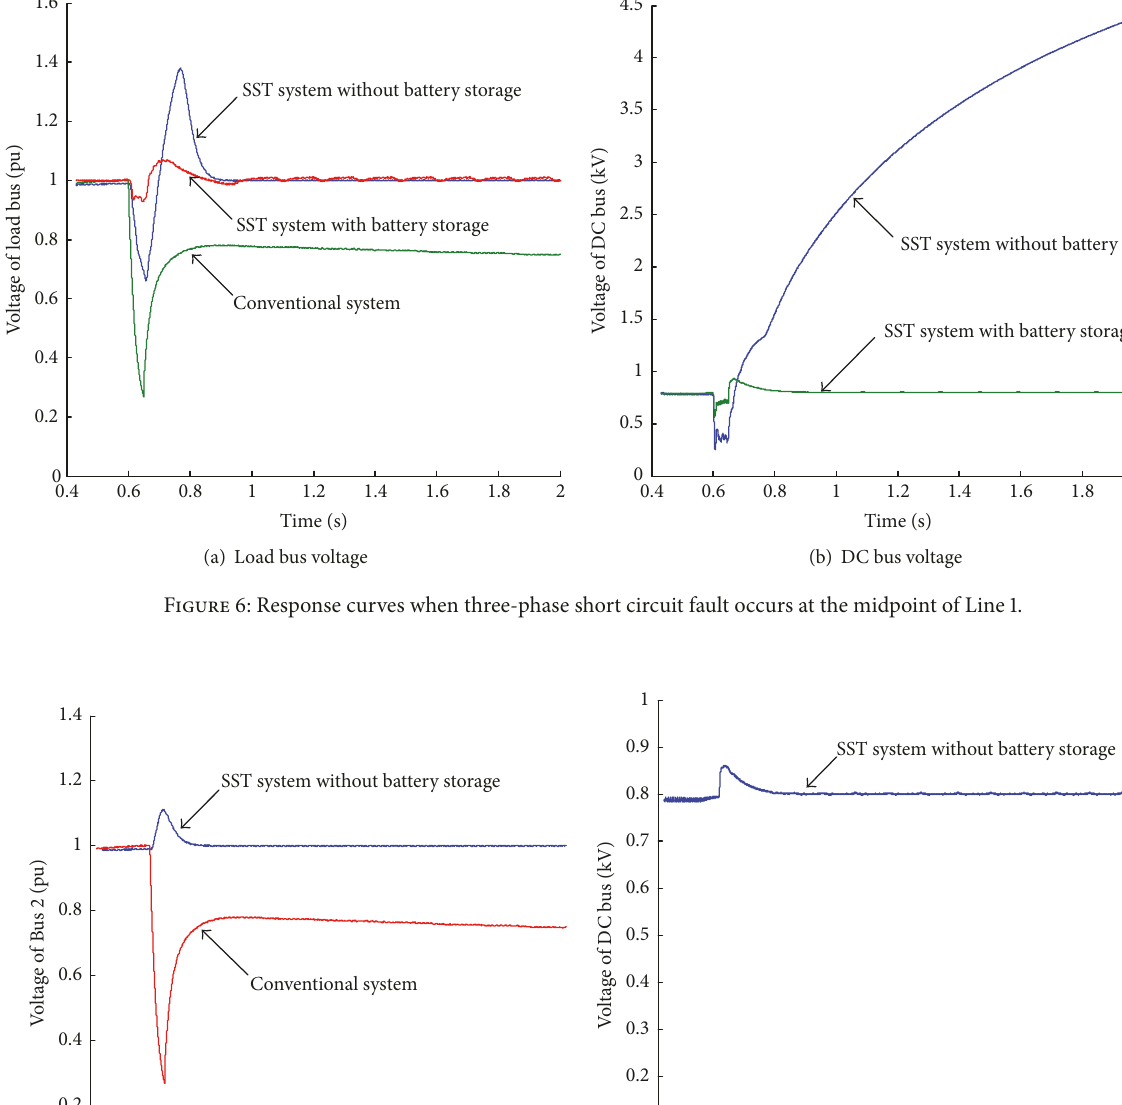
output of DGs is 𝑃 Σ + 𝑗𝑄 Σ , the load bus voltage drops to 𝑈 󸀠